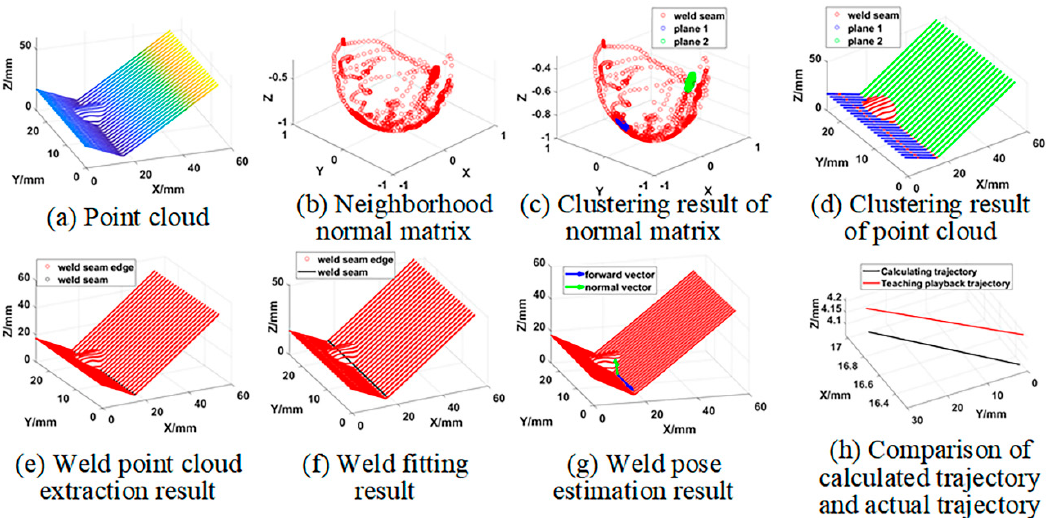
Figure 13. The influence of positioning welding seams on 3D zigzag-line welding seam pose information extraction. Table 2. Welding seam extraction